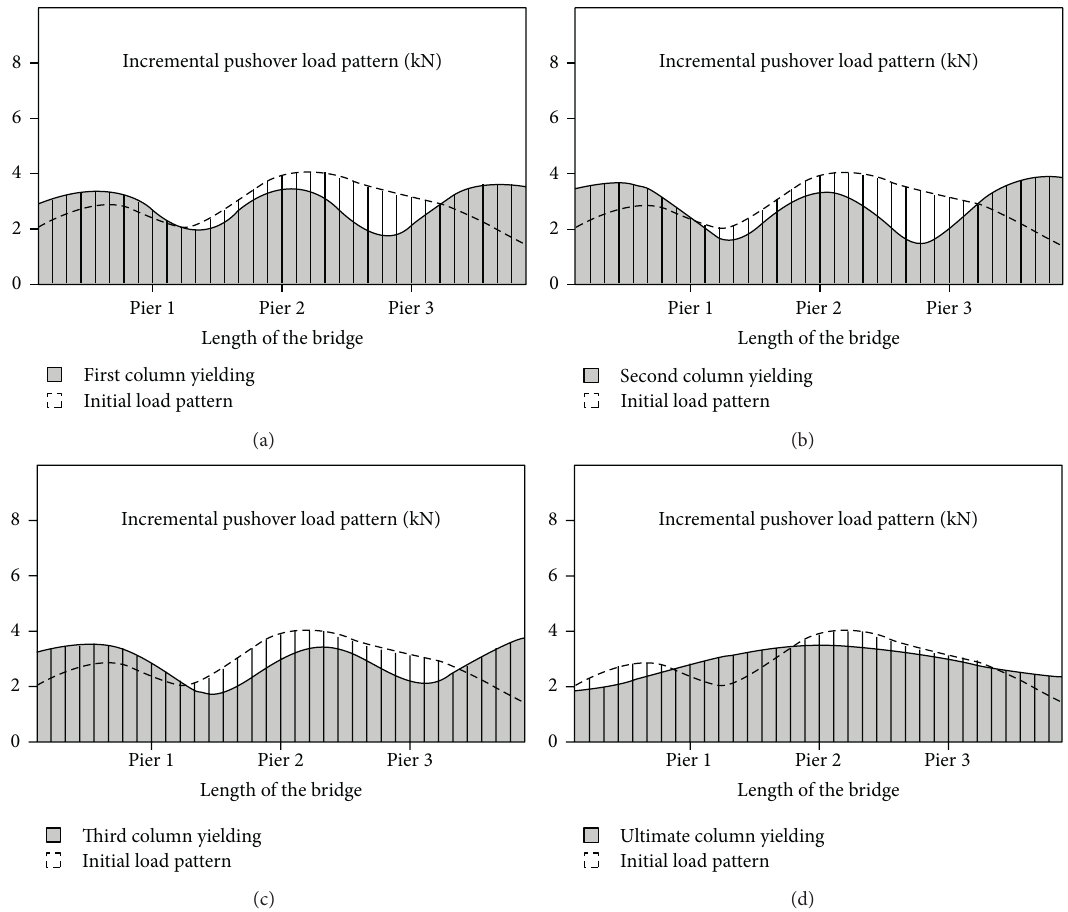
Figure 9: Variation of the pushover load pattern during the analysis (for B123).